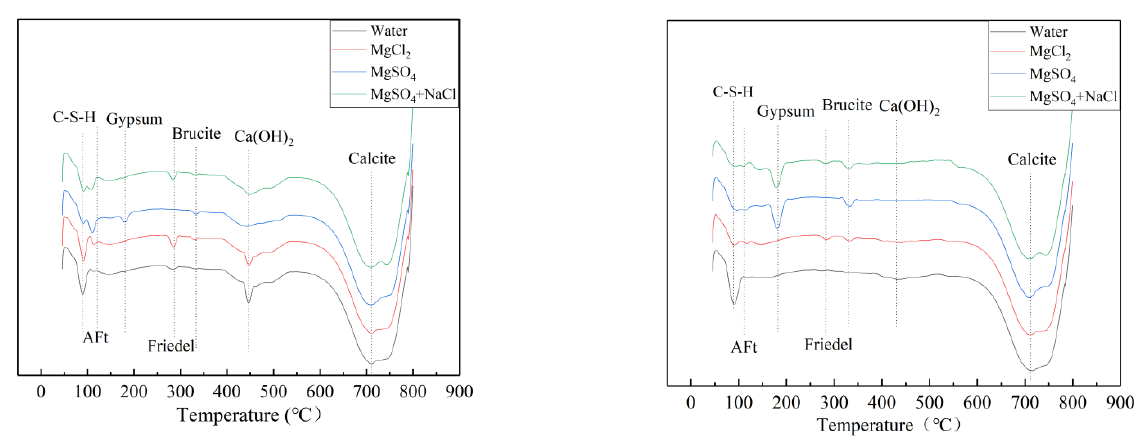
Figure 13. DTG diagram of erosion solution containing SO 4 2− .